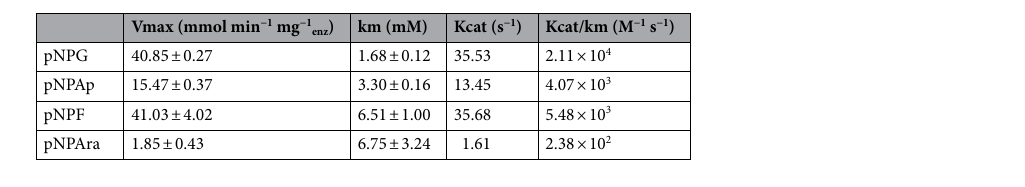
Table 2. Kinetic parameters of ThABF against selected